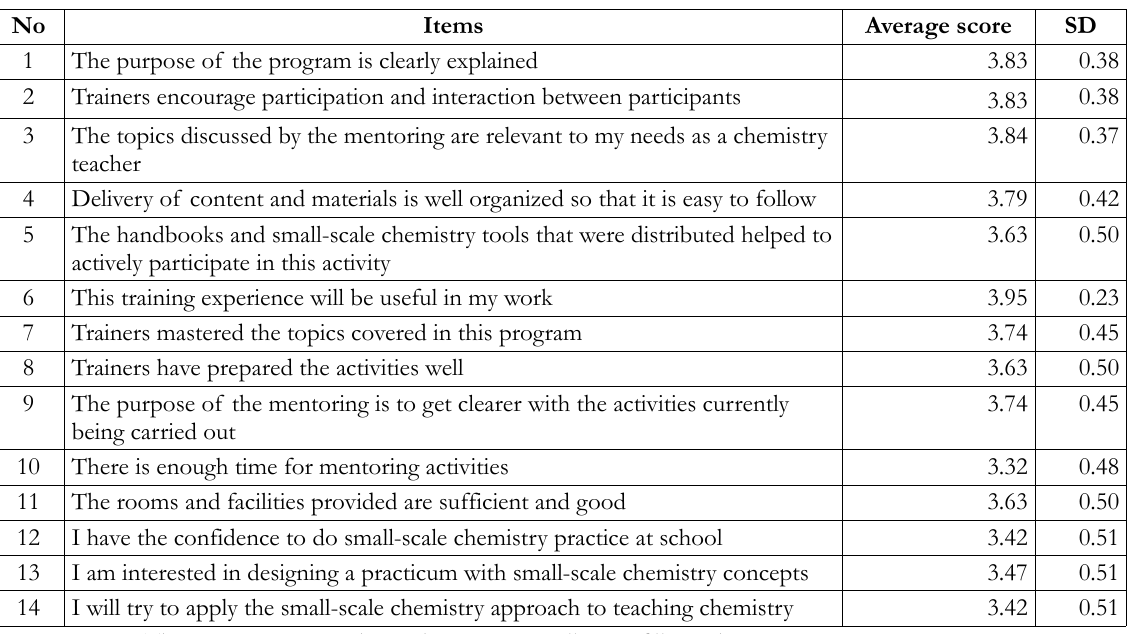
Table 3. Evaluation of workshop activities implemented in the chemistry teacher group